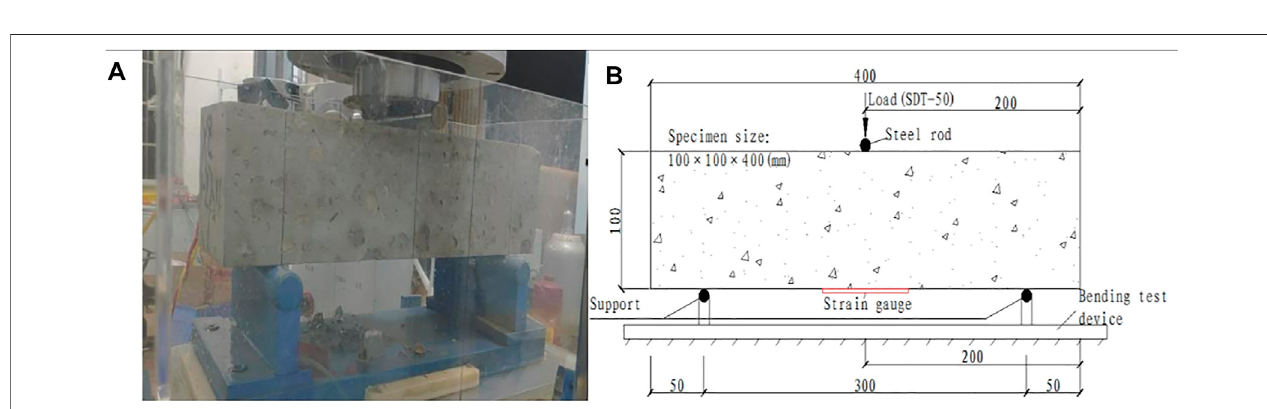
FIGURE 3 | Test with 300 mm base cavity. (A) test devices; (B) Loading position and support.